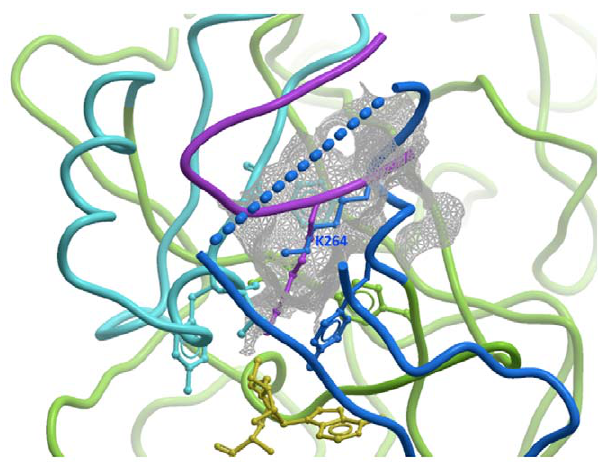
Figure 7. Auto-inhibitory conformation of SUV39H2. In our structure of SUV39H2, the C-terminus of the Post-Set domain (blue) adopts a conformation that positions its K264 side-chain (blue sticks) half-way into the substrate lysine channel (gray mesh). The H3K9me peptide (magenta) from a superimposed GLP-H3K9me structure is shown as a reference. SET and Post-SET of SUV39H2 are colored green and blue respectively.